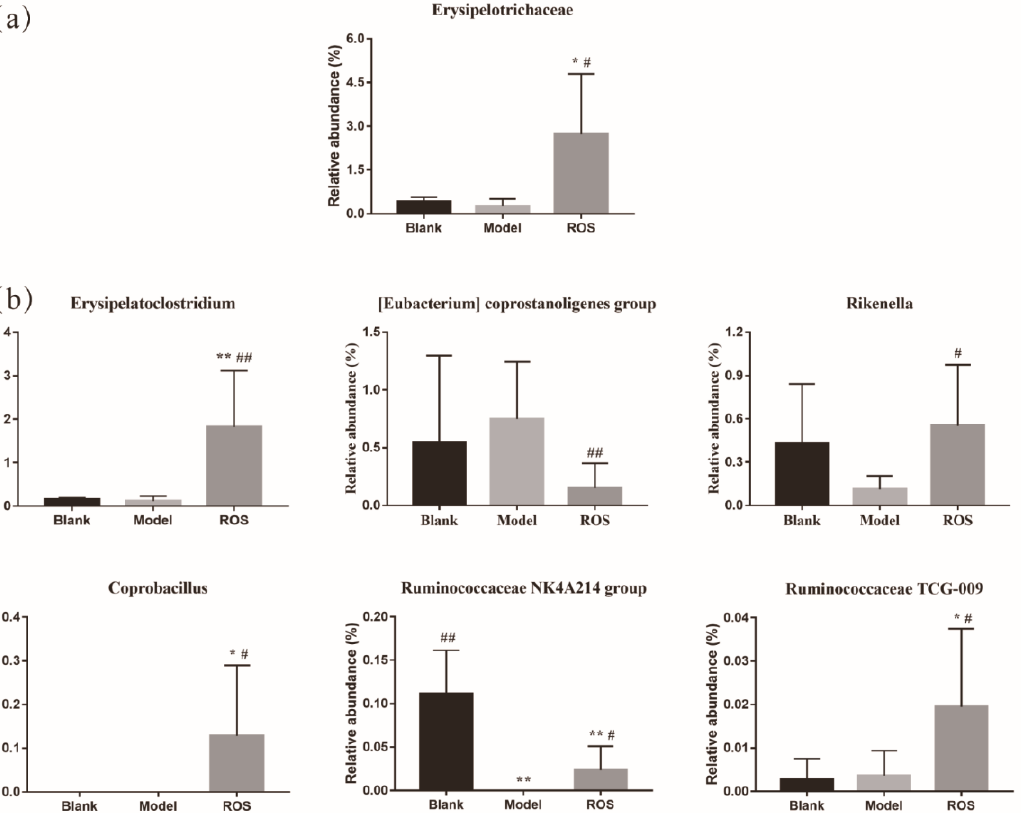
Figure 4. Alteration in the level of family ( a ) and alteration in the level of genus ( b ). Blank: distilled water treated; Model: Loperamide treated; ROS: high-dose ROS treated. * p < 0.05 and ** p < 0.01 than in the blank group; # p < 0.05 and ## p < 0.01 than in the model group.